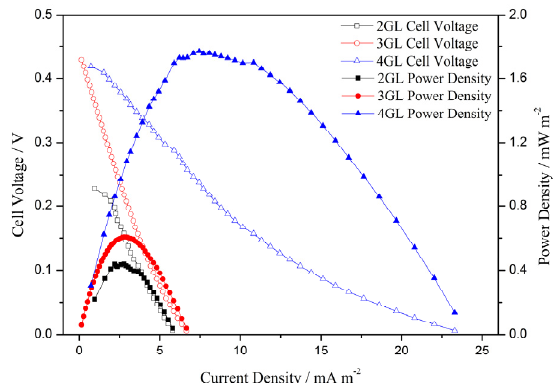
Figure 9. Linear scan voltammetry (LSV) results of anodes coated with two to four layers of GS.